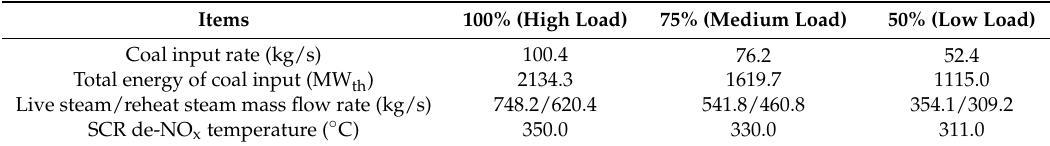
Table 2. Thermodynamic performance of the reference 1000 MW coal-fired power plant.